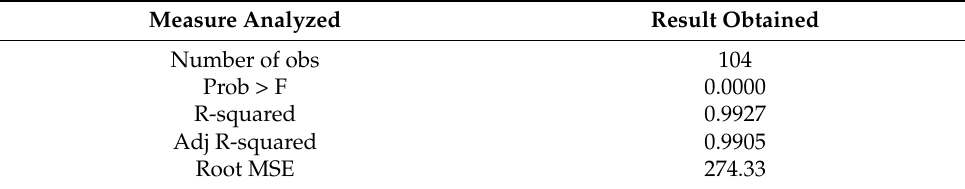
Table 3. Representative statistical measures of the proposed regression model